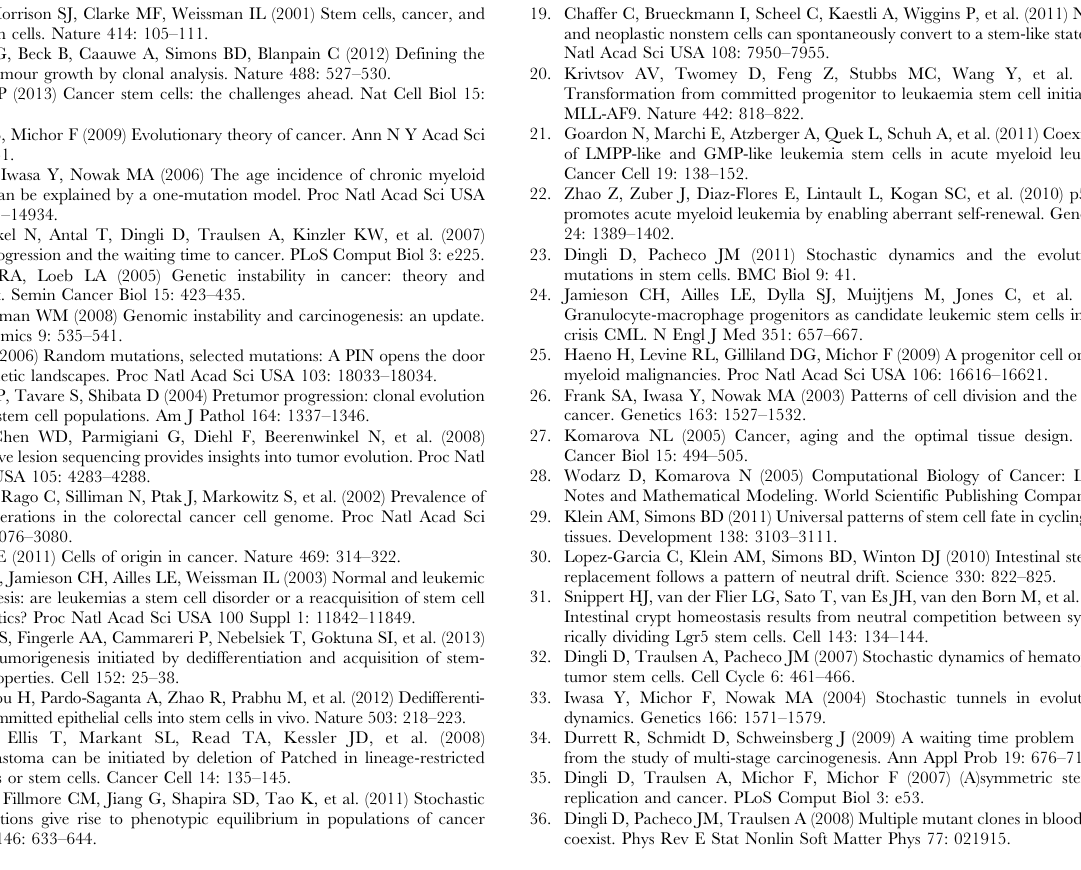
Figure S5 Characterization of exponential growth of two-mutant population in Model II. (A) The exponential l { (1 { g ) growth rate k ~ of the stem cell population does not T gen depend on the mutation rate ( u ~ 0 : 01,0 : 001, (cid:3)(cid:3) (cid:3) ,10 { 5 for g ~ 0, j ~ 1 ). (B) The time to exponential growth for different rates of asymmetric division (red g ~ 0 ; blue: g ~ 0 : 95 ) is roughly similar. Rate of dedifferentiation is d ~ 0 : 01 . n ~ 1000 points are used for each distribution. (EPS) Text S1 Analytic solutions and derivations, alternative models, and Matlab